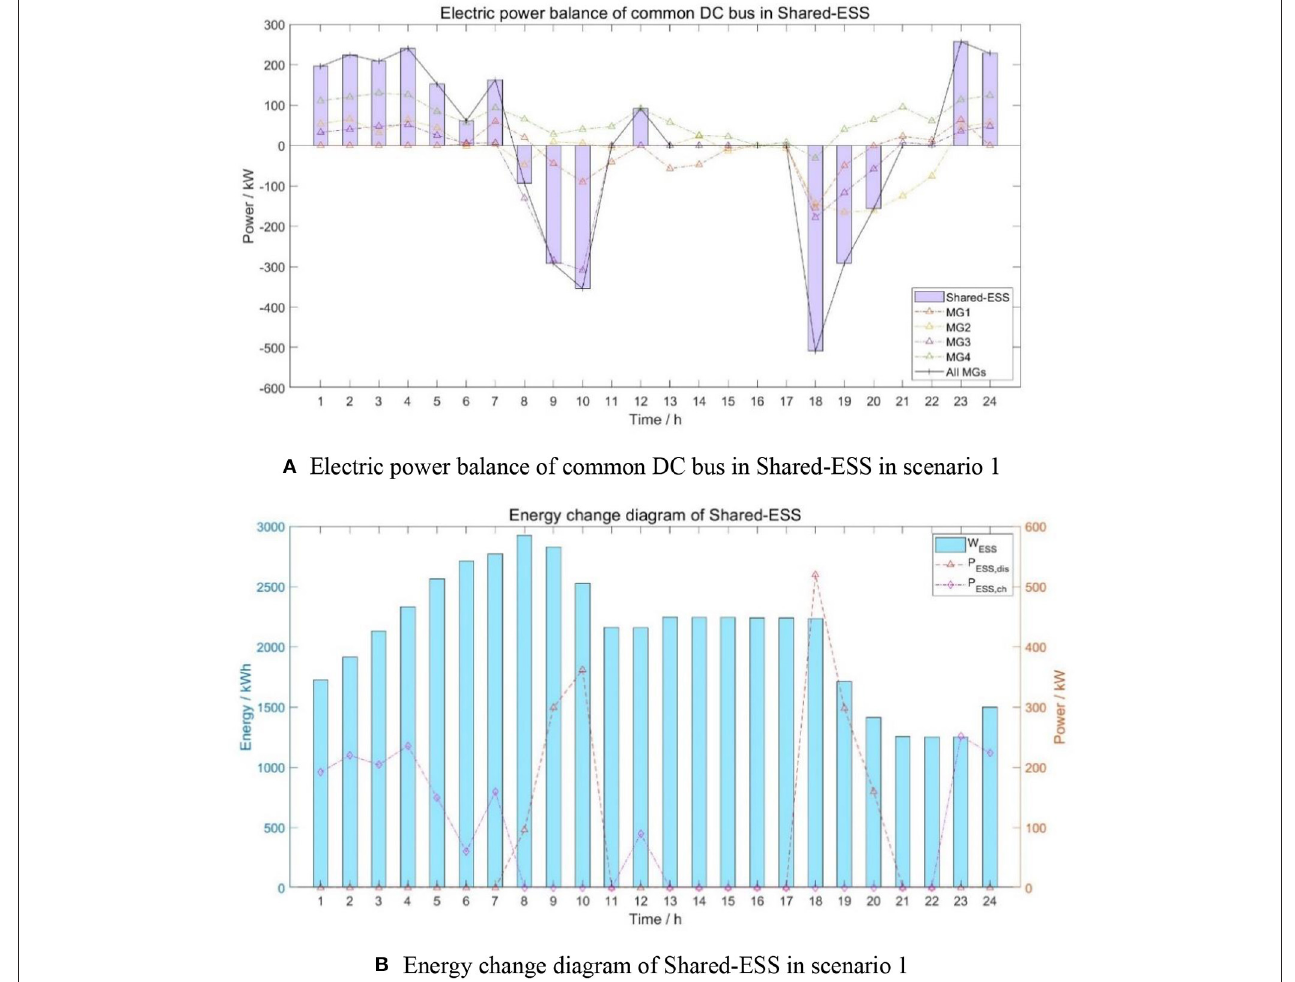
FIGURE 4 | The operating status of Shared-ESS in scenario 1. (A) Electric power balance of common DC bus in Shared-ESS in scenario 1. (B) Energy change diagram of Shared-ESS in scenario 1.